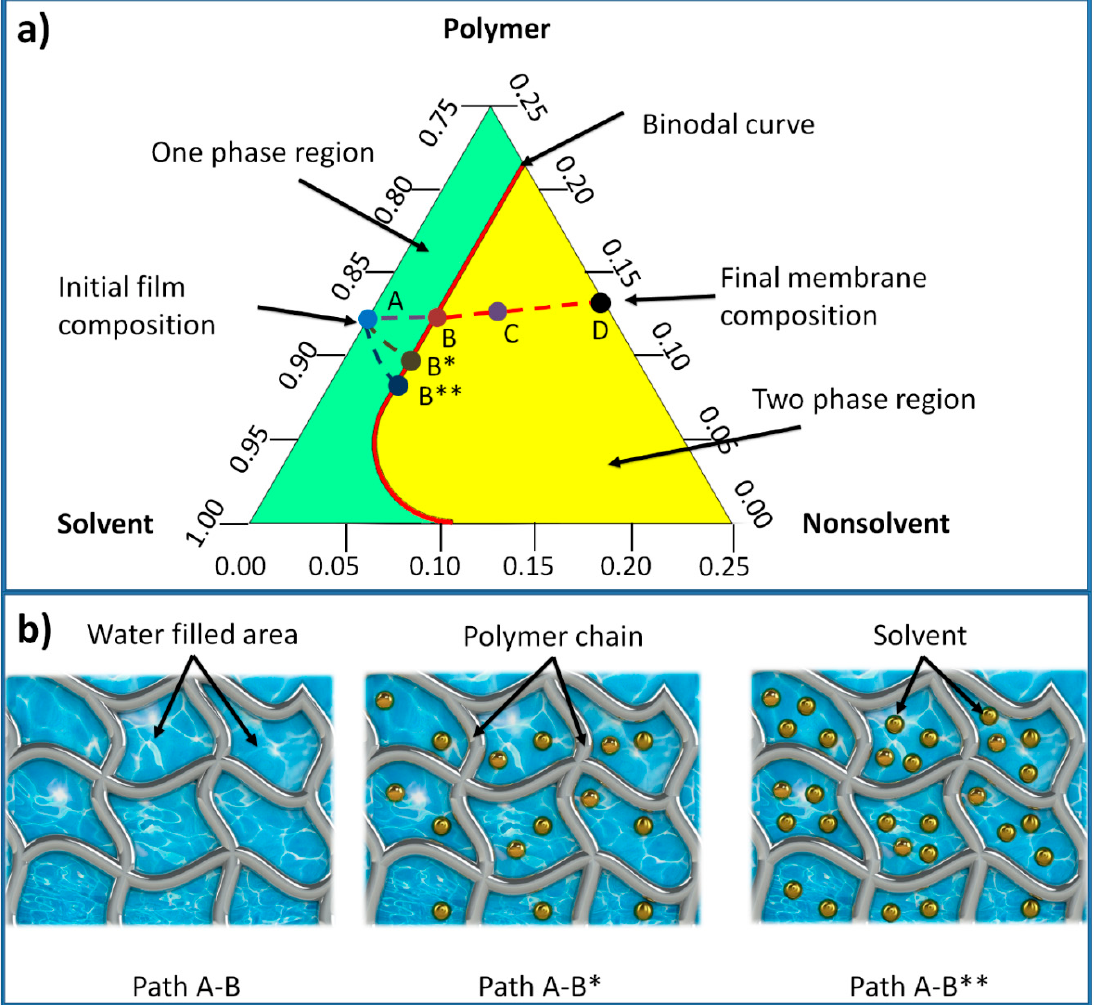
Figure 3. ( a ) Ternary phase diagram of a polymer/solvent/non-solvent system. ( b ) Schematic view